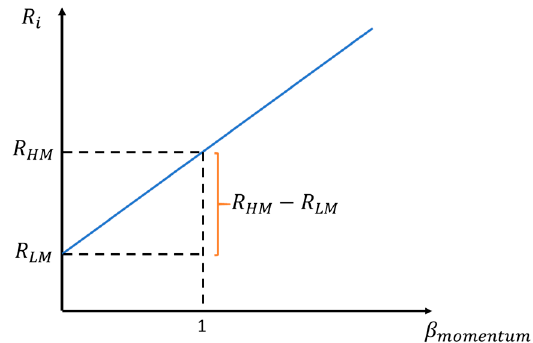
Figure A7. Positive relationship between expected return and momentum premium.